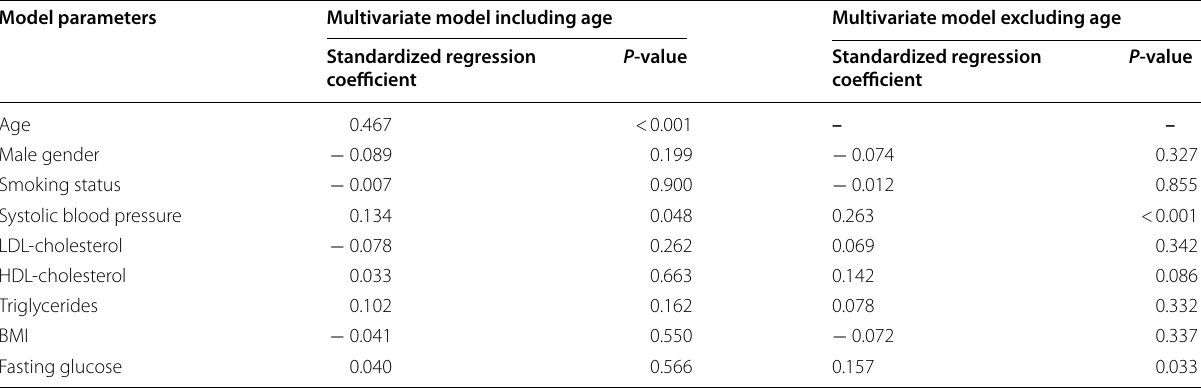
Table 4 Multivariate regression model of cardiovascular risk factors and carotid intima–media thickness considering and omitting